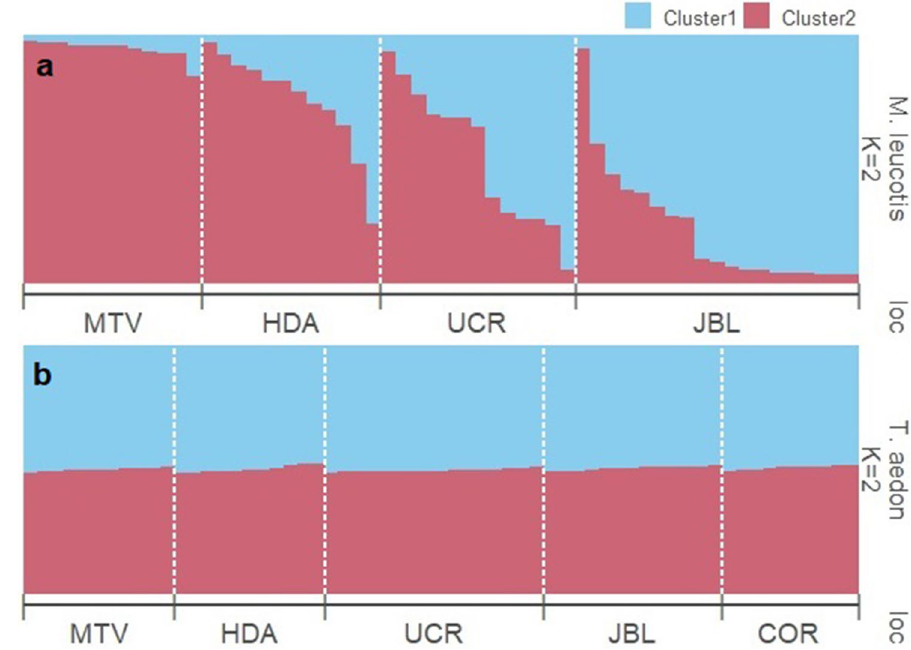
Figure 3. STRU CTU RE barplots for ( a ) White-eared ground-sparrow ( Melozone leucotis ) K = 2, and ( b ) House wren ( Troglodytes aedon ) K = 4. Plots are sorted by sampling location, bars are sorted by Cluster 1 proportion and each bar represents one individual, while colors represent each cluster, and its size corresponds to assignment proportion. MTV Monteverde, HDA Heredia, UCR University of Costa Rica, JBL Lankester Botanical Garden, COR Corredores.